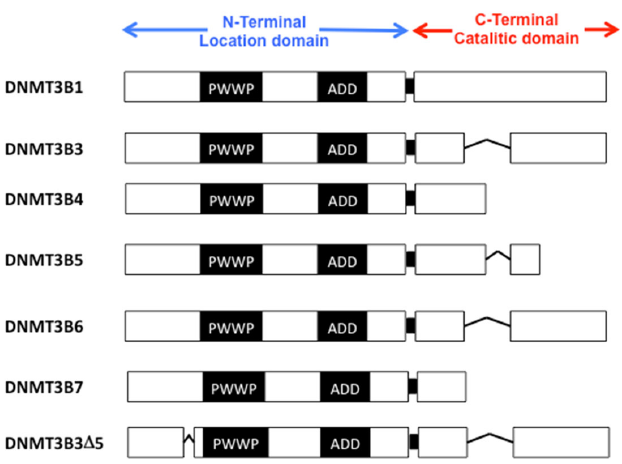
Figure 2. Structure of Human DNMT3B isoforms. Splice variants isoforms of DNMT3B have different characters. DNMT3B isoforms variates mammalians. Amino and carboxyl ‐ terminal domains variates. DNMT3B isoforms’ nuclear location variates during embryonic development and in tissue specificity. Moreover, it has been found that DNMT3B isoform variates in cancer with their own origin tissue. Suggesting that DNMT3B isoforms have an important role in cancer development. Abbreviatures: motif of interaction with pro ‐ trp ‐ trp ‐ pro (PWWP), and ATRX, DNMT3, DNMT3L domain (ADD).